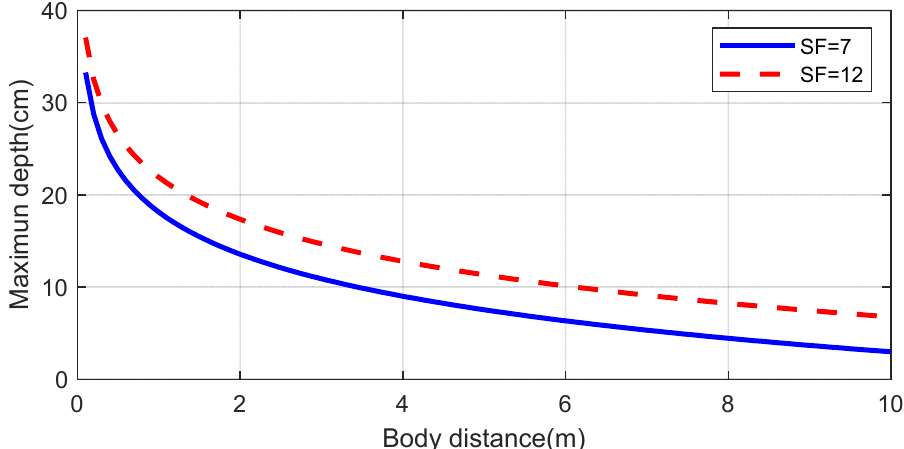
Figure 12. Simulated maximum depth for an implanted backscatter as a function of the distance to the body using the parameters of Table 1 for the monostatic case with a spreading factor SF = 7 and 12. Propagation model parameters: n 1 = n 2 = 2.5, Fade Margin = 10 dB.